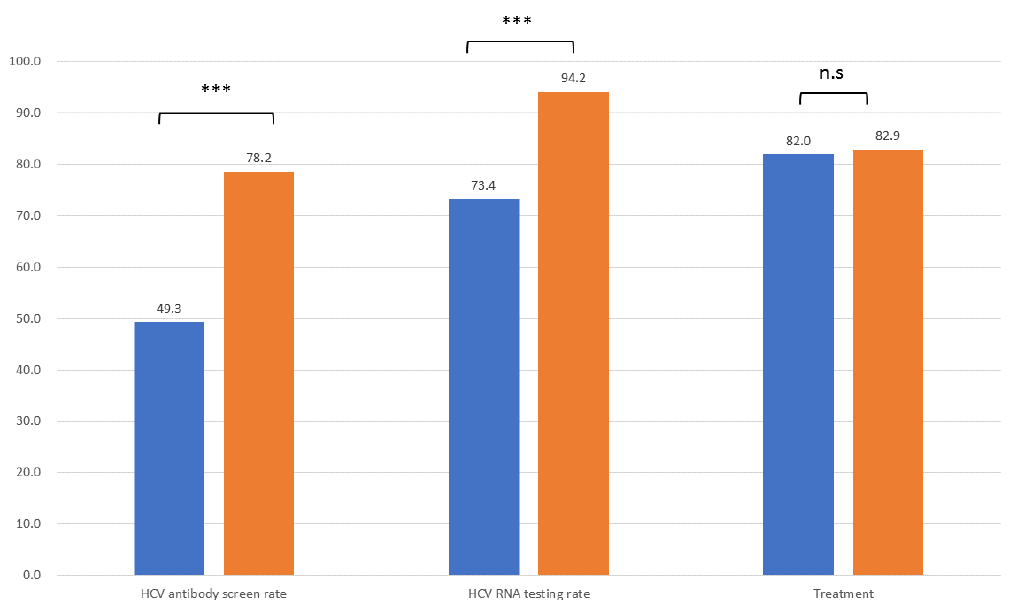
Figure 3. The HCV-Ab screening rate, HCV RNA testing rate, and HCV treatment rate before (blue bar) and after (orange bar) the micro-elimination program. *** p < 0.0001.